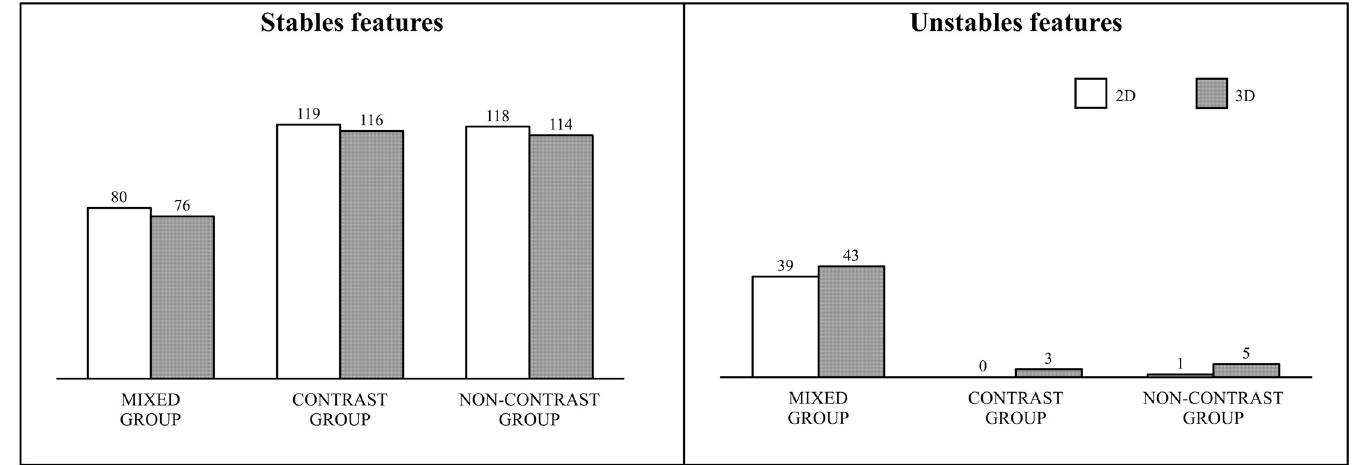
Fig 3. Stability of the radiomic features for the three groups assessed. Features were divided in 2D or in 3D.